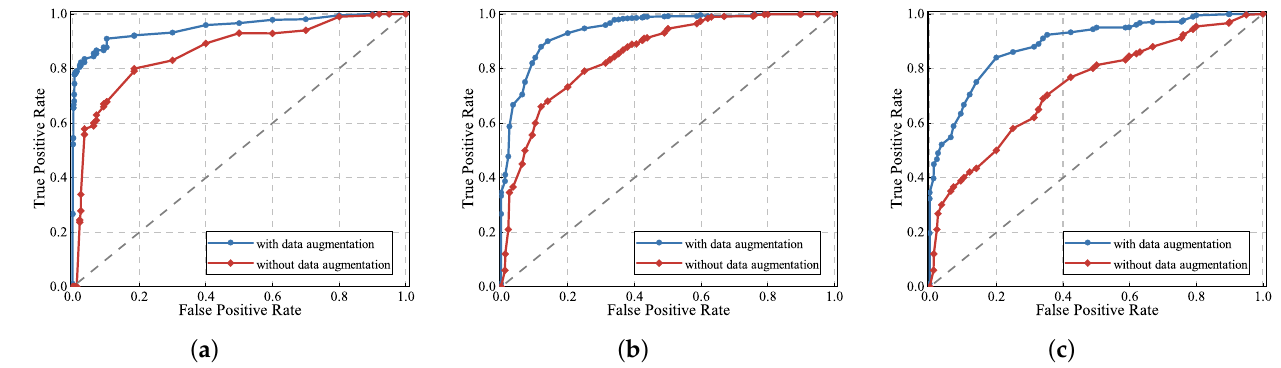
Figure 11. Impact on recognition performance of single gesture, continuous gesture and sign language gesture when data augmentation is used or not. ( a ) Single gesture; ( b ) continuous gesture; and ( c ) sign language gesture.